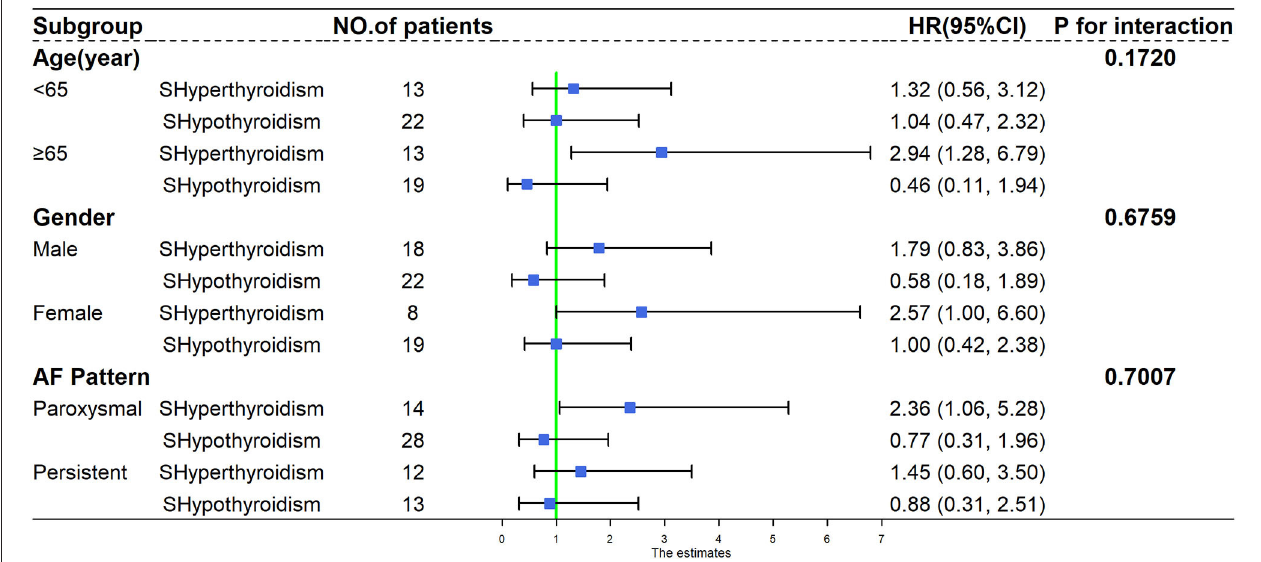
Frontiers in Cardiovascular Medicine |